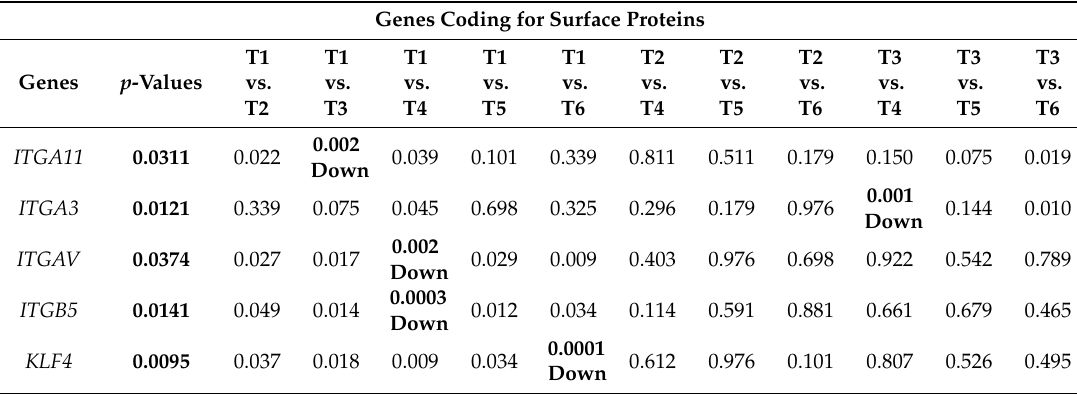
Table 4. Di ff erentially expressed genes coding for surface proteins. Genes Coding for Surface Proteins